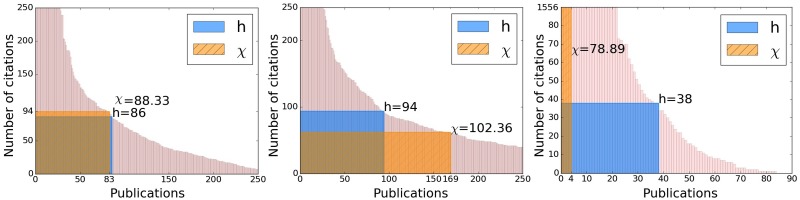
Examples of authors for the Nobel prize winners data set: k ≈ h (left) k > h (middle) k < h (right).